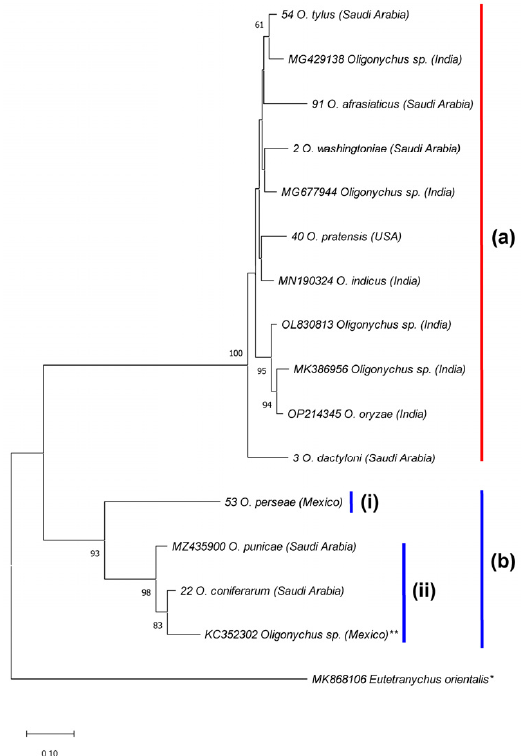
Figure 7. NJ phylogenetic tree based on 16 ITS2 sequences, representing 15 Oligonychus species. Eutetranychus orientalis * was used as an outgroup taxon. A total of 11 Oligonychus species belong to the subgenus ( a ) Reckiella , whereas four Oligonychus species (** including a cryptic Oligonychus sp., previously claimed as O. punicae from Mexico) [7] belong to the species groups ( b - i ) peruvianus and ( b - ii ) coffeae of the subgenus Oligonychus [3]. Numbers on tree branches are bootstrap values obtained from 1000 replicates.